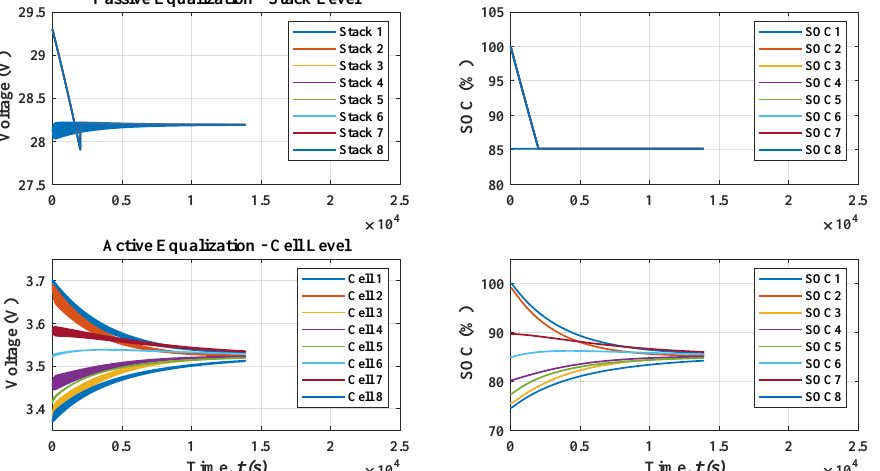
Figure 9. Passive stack-level and active cell-level hybrid equalization.